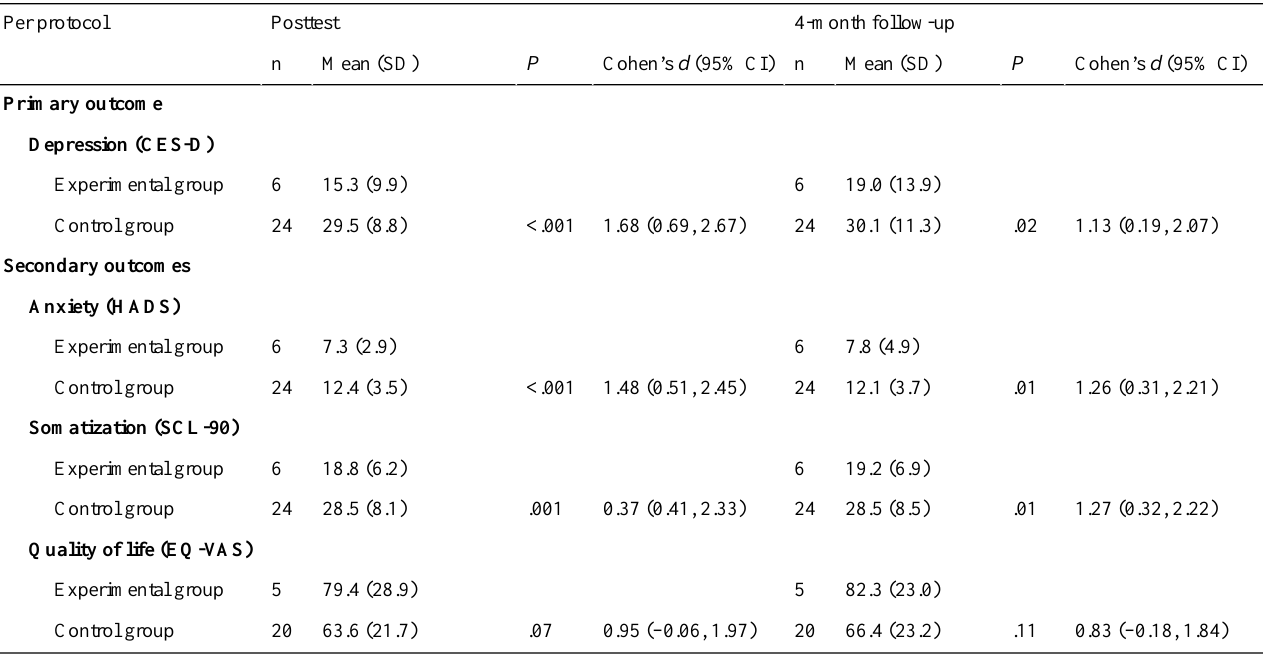
Table 4. Study outcomes of participants at posttest and follow-up including between-group effect size (Cohen’s d ): per protocol (n=30).